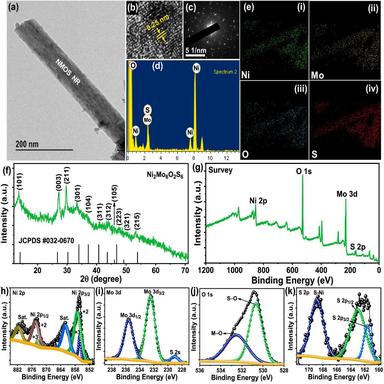
(a) TEM image of NMOS-1:3 NR. (b) HR-TEM image and (c) SAED pattern of NMOS-1:3 NR. (d) EDX spectrum and (e) elemental mapping images of NMOS-1:3 NRs. (f) XRD pattern and (g) XPS survey scan spectrum of NMOS-1:3 sample. High-resolution XPS spectra of (h) Ni 2p, (i) Mo 3d, (j) O 1s, and (k) S 2p.